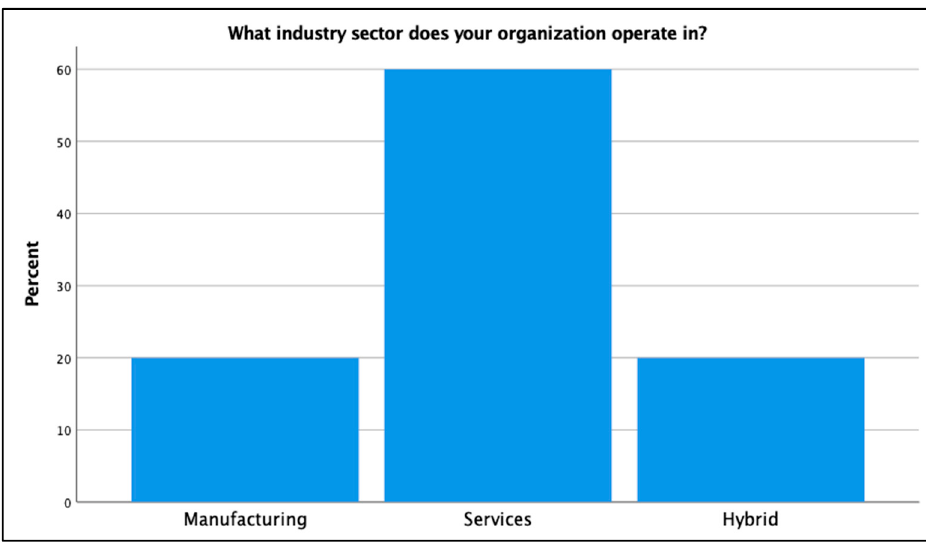
Figure 5 . Company Industry Sector.